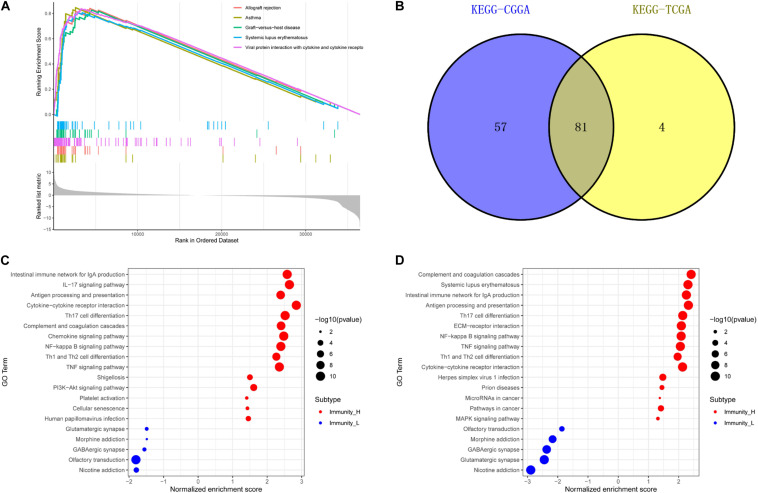
Function enrichment of genes related to immune gene set by GSEA. (A) KEGG in TCGA. (B) The intersection of related pathways is based on TCGA and CGGA. The bubble chart of the enrichment pathway is in TCGA (C) and CGGA (D).